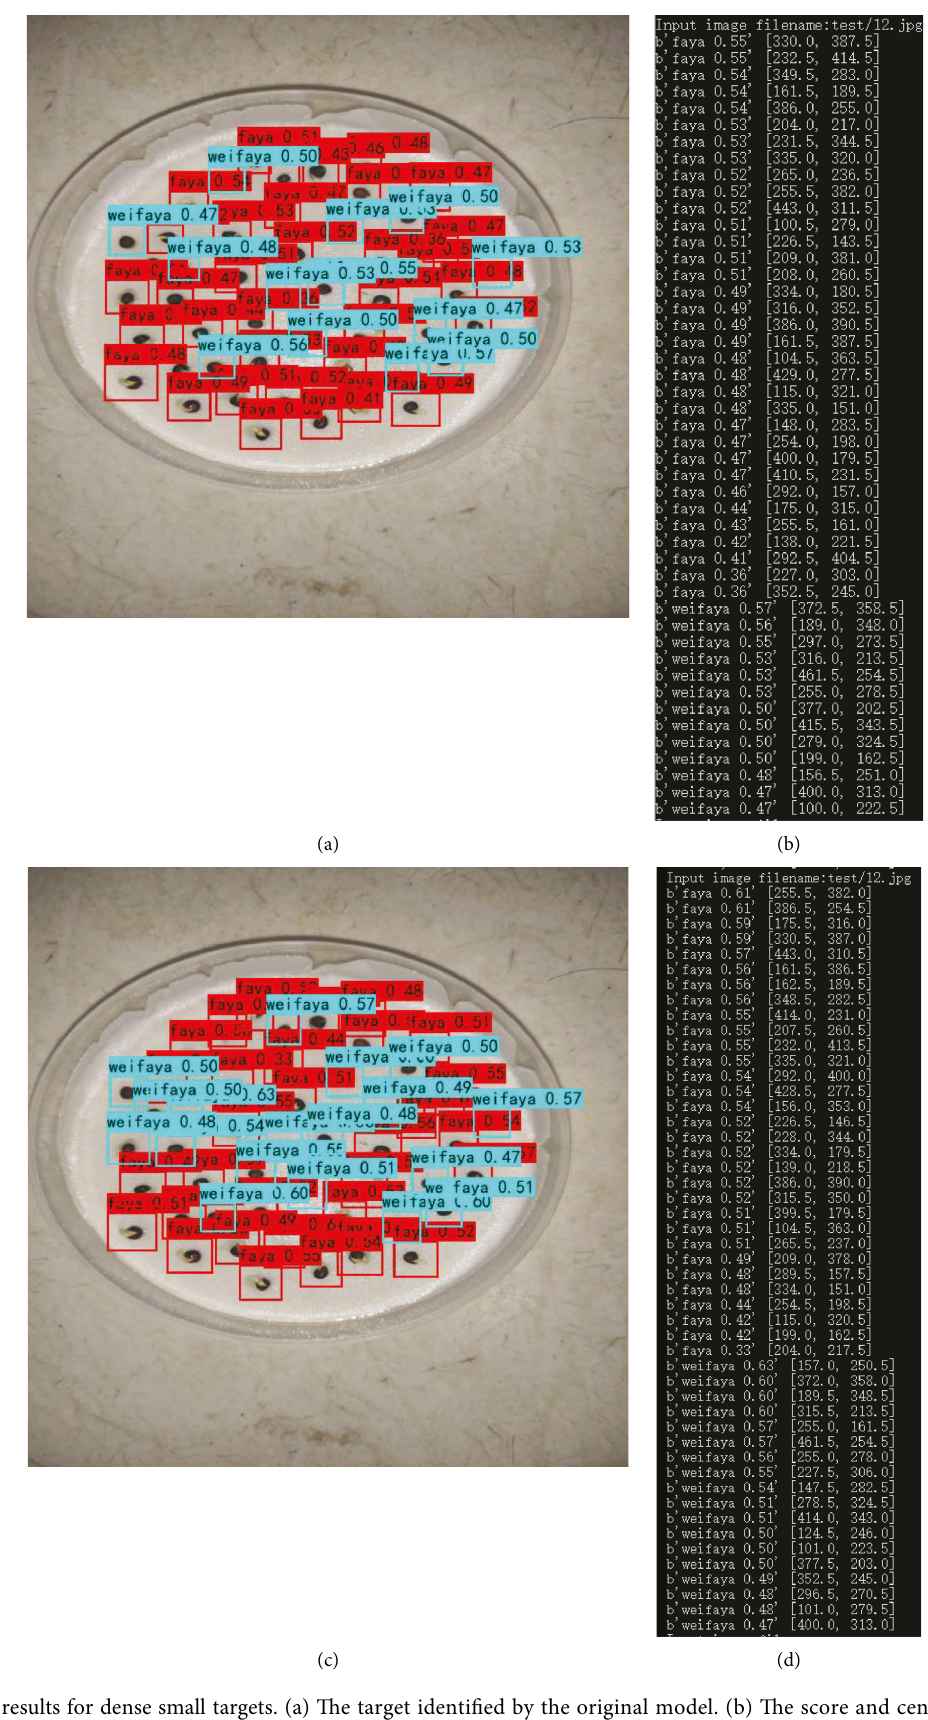
Figure 10: Test results for dense small targets. (a) The target identified by the original model. (b) The score and center position of the original model. (c) The target identified by the new model. (d) The score and center position of the new